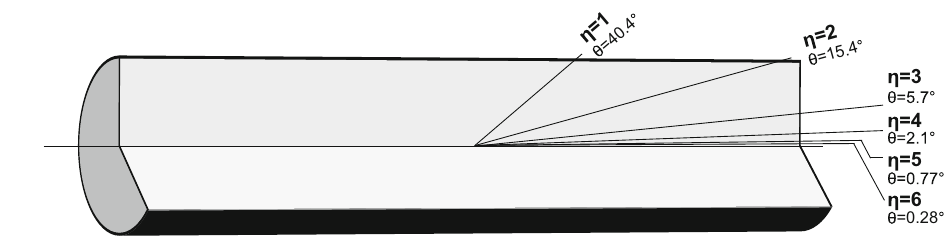
Fig. 1 Schematic showing the correspondence between pseudorapidities and angular coverage envisioned for tracking and calorimetry at FCC-hh. (The reference cylinder indicates the proportions of an instrumented region roughly 55m long with a 6m